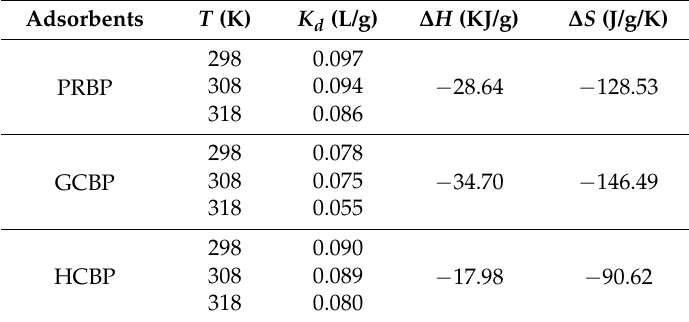
Table 4. The thermodynamic parameters of DCF